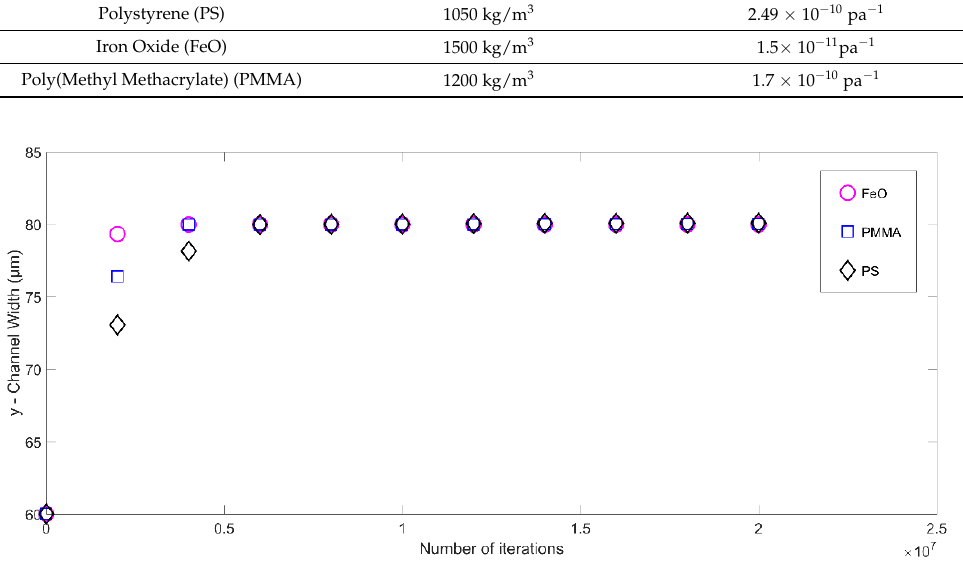
Figure 9. The trajectory of microparticles with different density and compressibility values and subjected to acoustic radiation force in the microchannel.